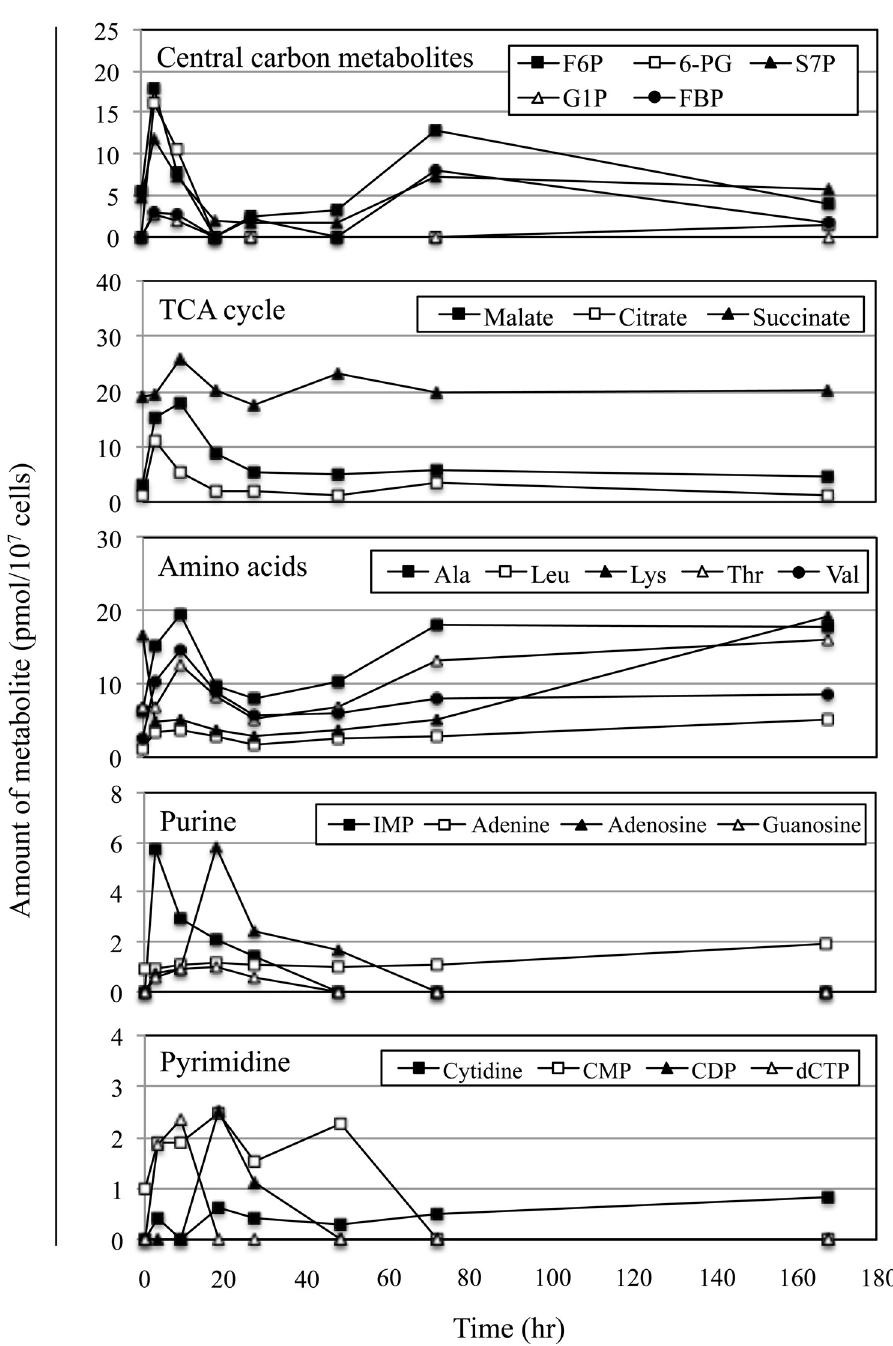
Fig 4. Metabolite profiles of Synechococcus 7942 during batch culture. The stationary culture of Synechococcus 7942 wild-type was diluted to OD 750 = 0.2 in fresh BG11 medium. After 18 hr in the dark, cultures were transferred to illuminated conditions (time 0). Samples were harvested at various times points post-transfer. The absolute amounts (pmol per 10 7 cells) of metabolites were determined at each time point with CE-TOFMS. The data show remarkable changes at each phase in central carbon metabolites, TCA cycle metabolites, amino acids, purines, and pyrimidines. Raw data and additional figures are included in S2 Table, and S2 – S5